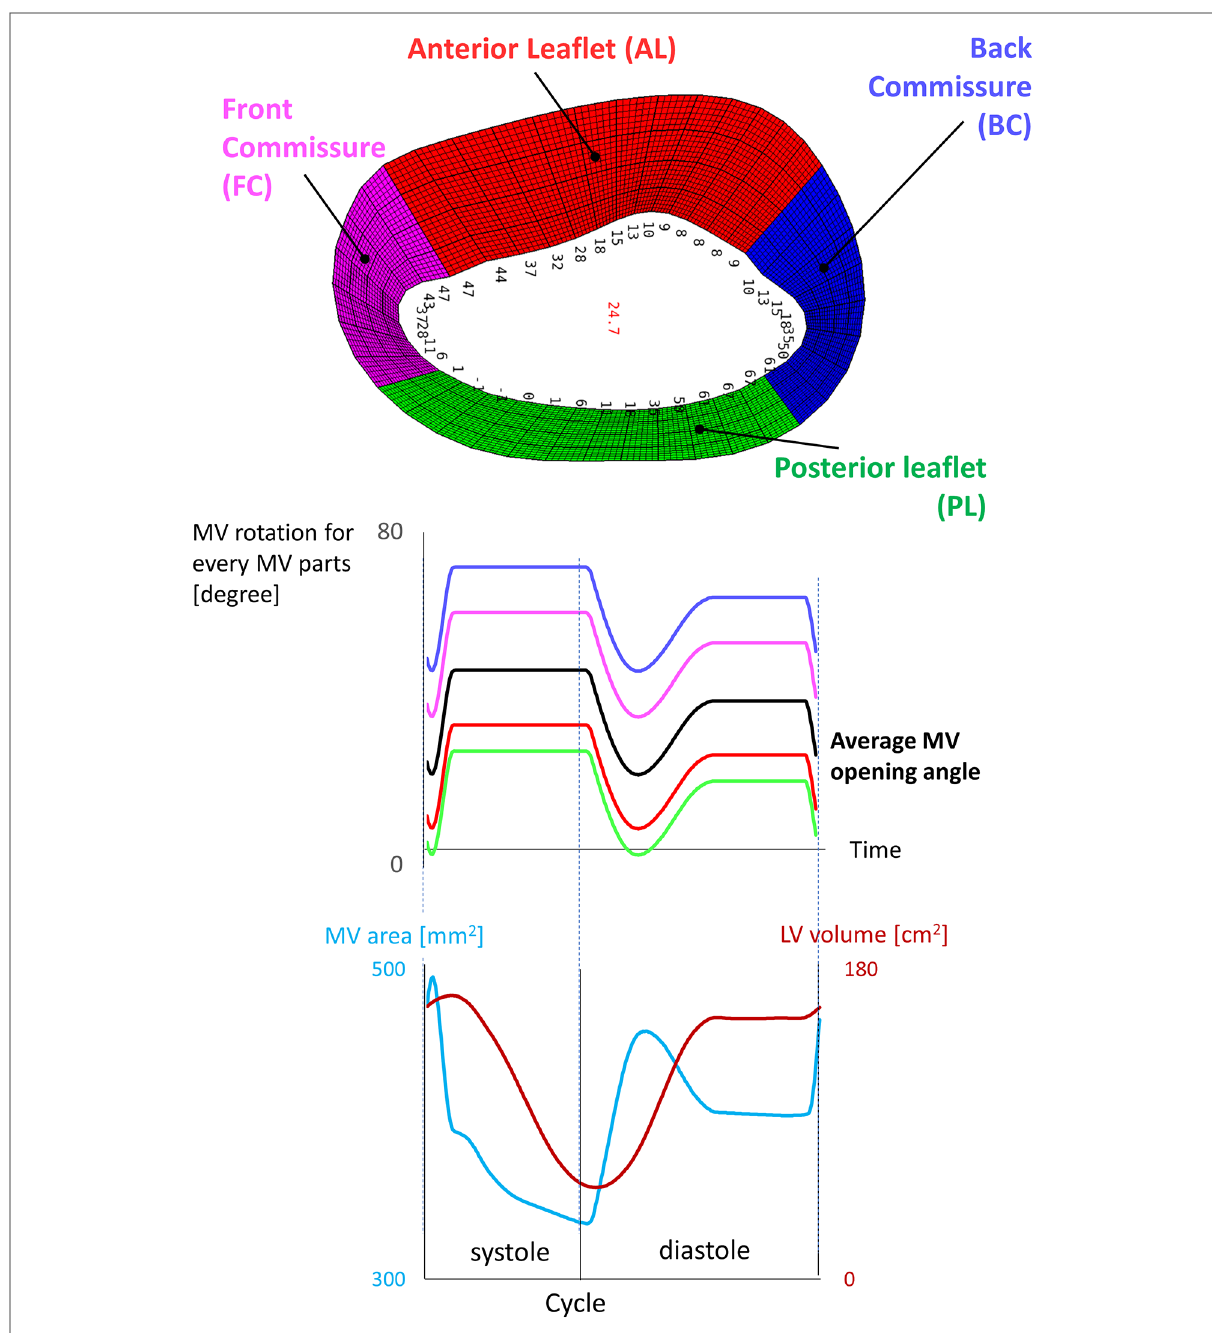
FIGURE 2 Kinematic model of the mitral valve reporting the average angle for each zone of the